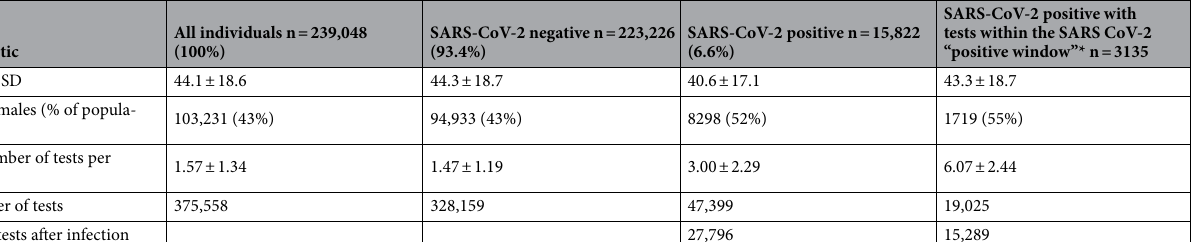
Table 1. Baseline characteristics of study cohort of SARS-CoV-2 tested individuals. *“Positive window” refers to the COVID-19 positive period in individuals who had additional NP PCR tests between their first and last documented positive SARS-CoV-2 tests. SD Standard Deviation.